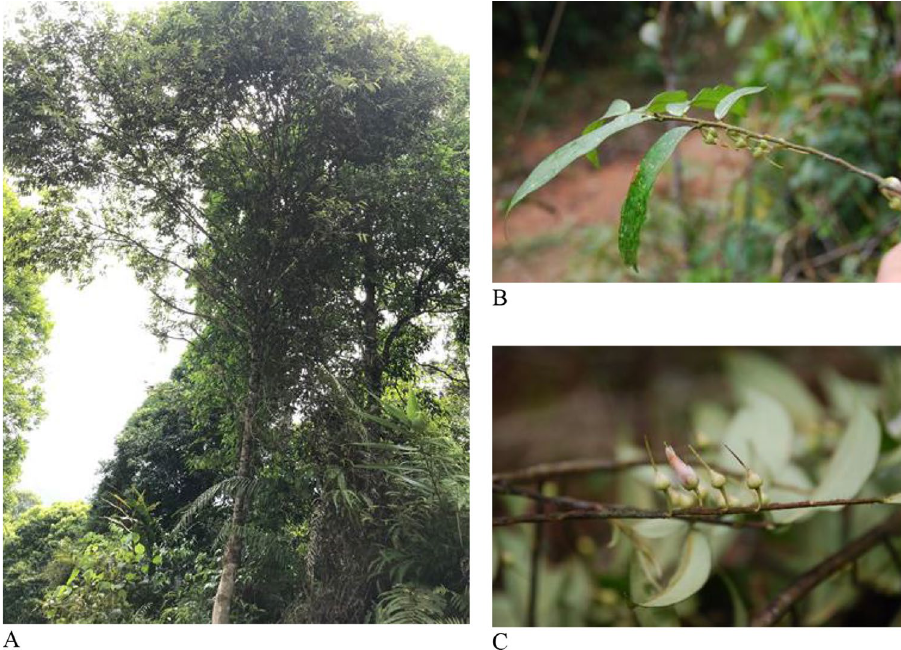
Figure 8. Morphological characteristic of A. megaphylla Hu. ( A ) Habit; ( B ) flowering twig; ( C ) bud and flower; Photos by Huu Quan